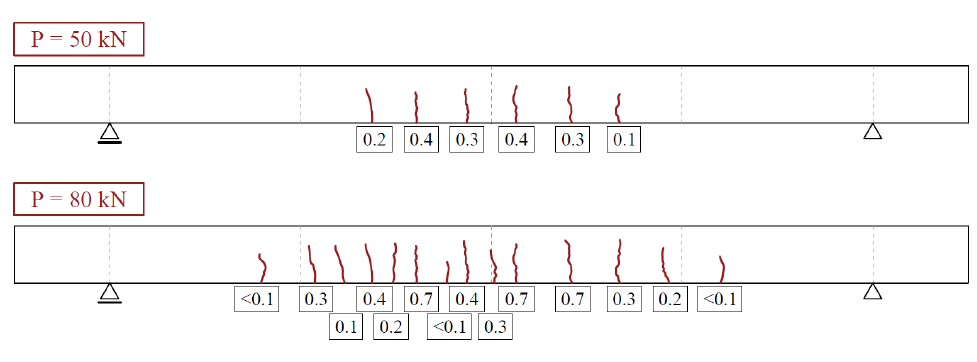
Figure 4. Crack patterns of tested slab at 50 and 80 kN load levels,